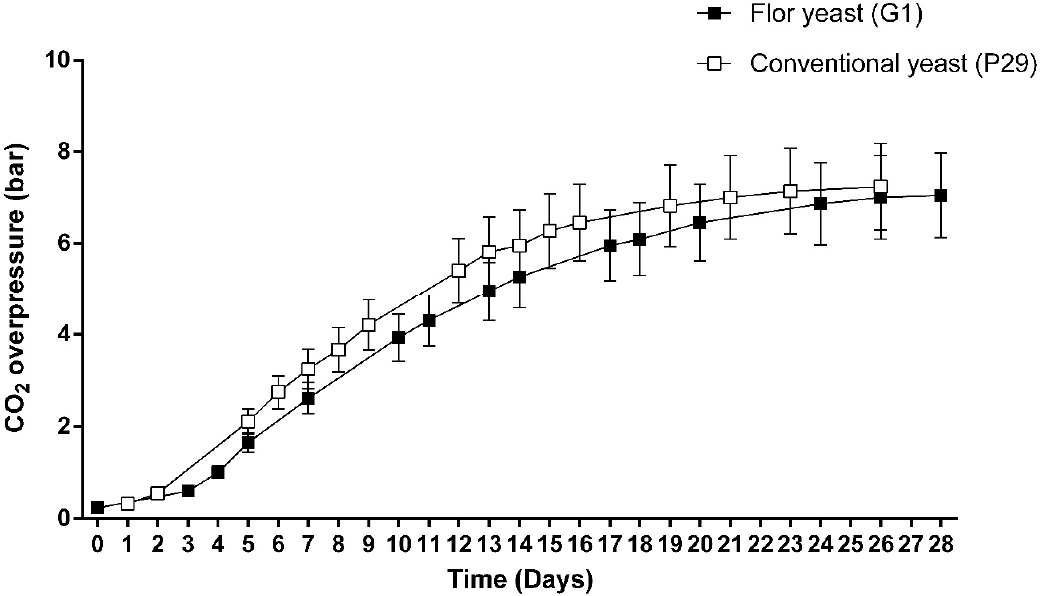
Figure 1. Evolution of endogenous CO 2 released by flor yeast and conventional yeast during the second fermentation in Spanish sparkling wine (cava) elaboration (Porras-Agüera et al. 2019) [20].